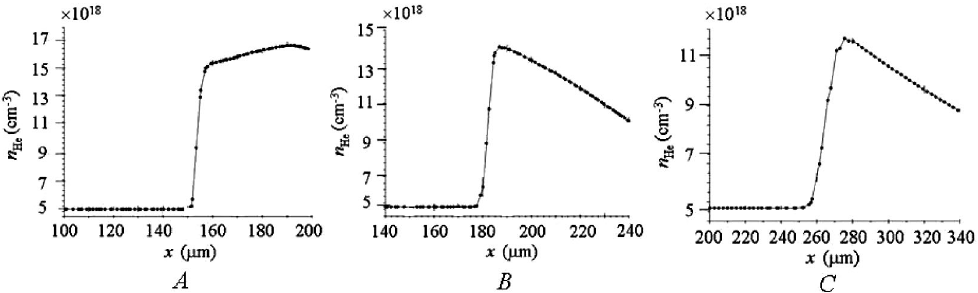
FIG. 6. The density transitions along the x direction through points A ð x; y ¼ 250 Þ , B ð x; y ¼ 150 Þ , and C ð x; y ¼ 50 Þ of Fig. 5, respectively.